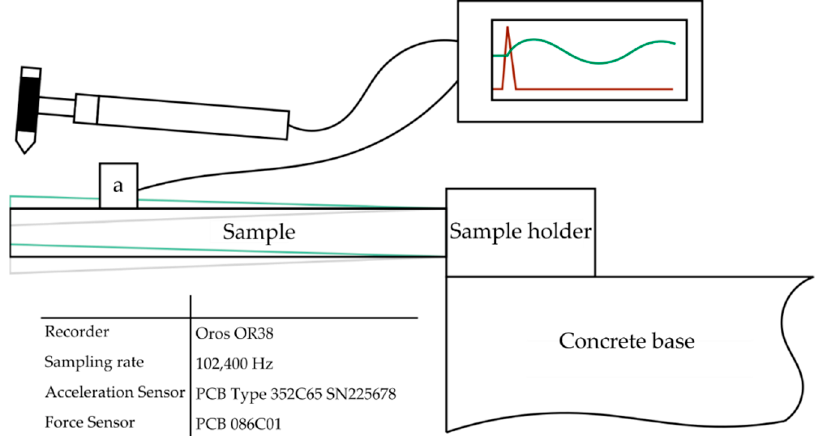
Figure 4. Measurement setup for the free oscillation test.